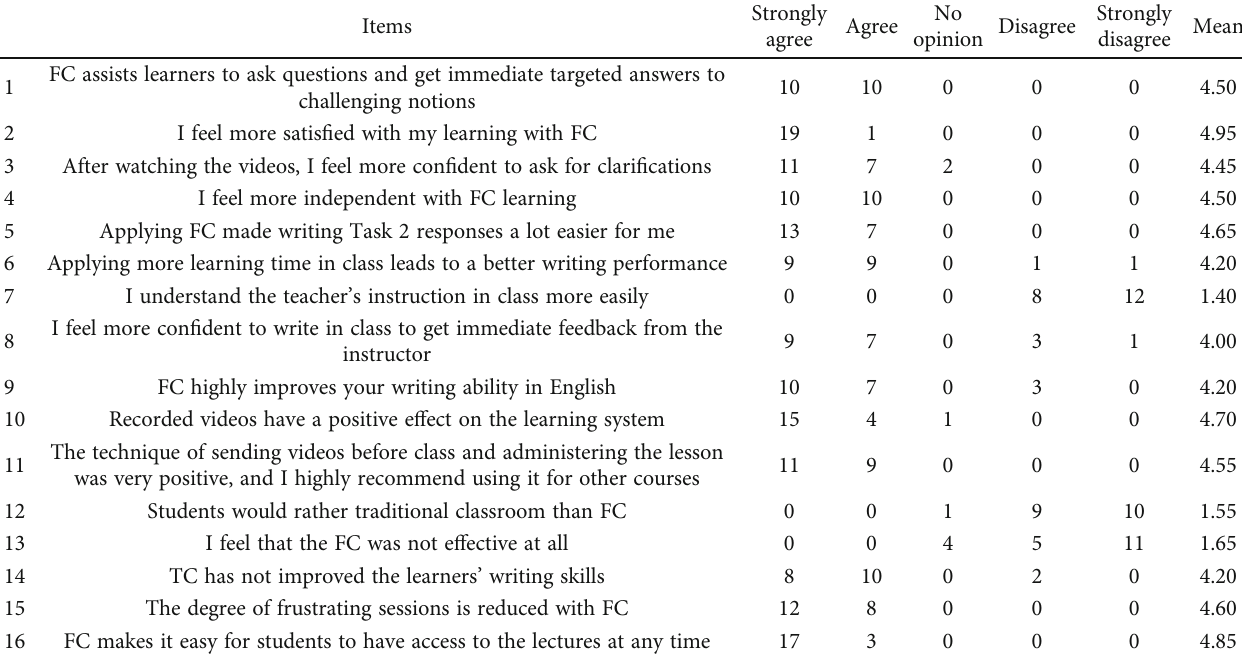
Table 6: Results of attitude questionnaire.